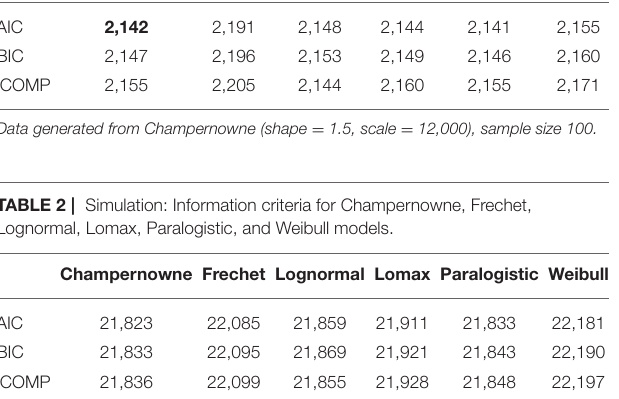
TABLE 6 | Simulation: Information criteria for Champernowne, Frechet, Lognormal, Lomax, Paralogistic, and Weibull models. Champernowne Frechet Lognormal Lomax Paralogistic Weibull